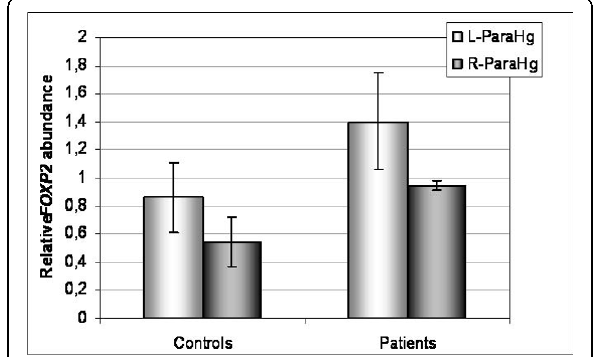
Figure 4 Levels of FOXP2 expression in parahippocampus gyrus brain area